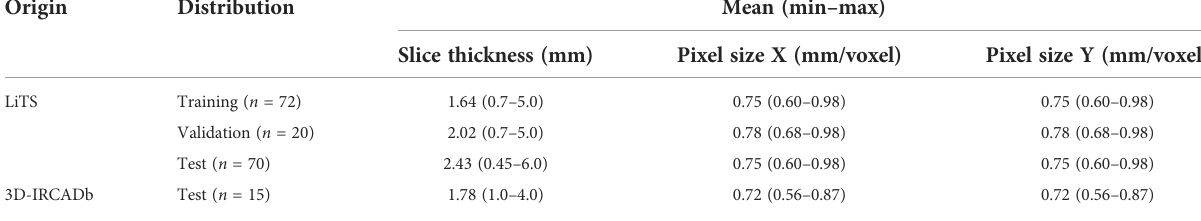
TABLE 1 Image acquisition parameters of the LiTS challenge for the training, validation, and test